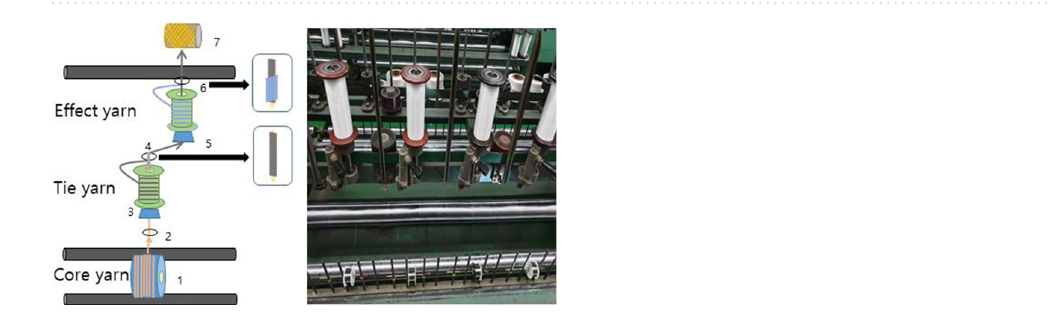
Figure 3. Manufacturing of the double-layered tungsten wire composite yarn using PET fiber containing BaSO